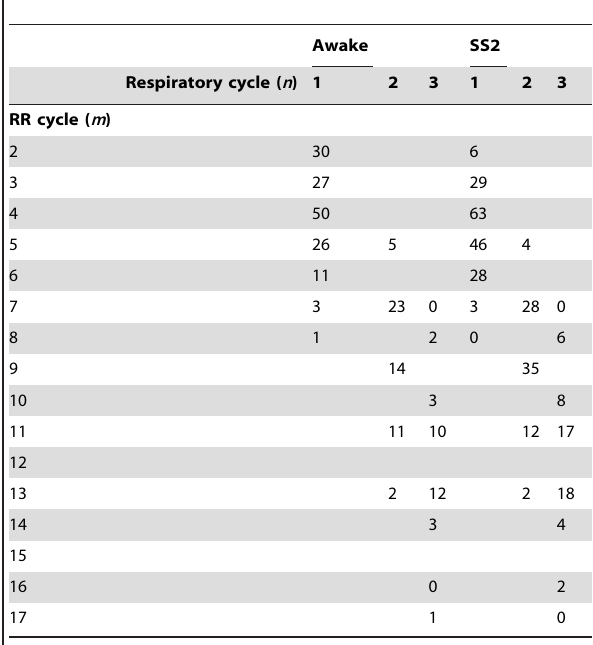
Each number represents the mean of the results obtained from 213 patients for the specific m : n coordination as observed during a particular sleep stage.